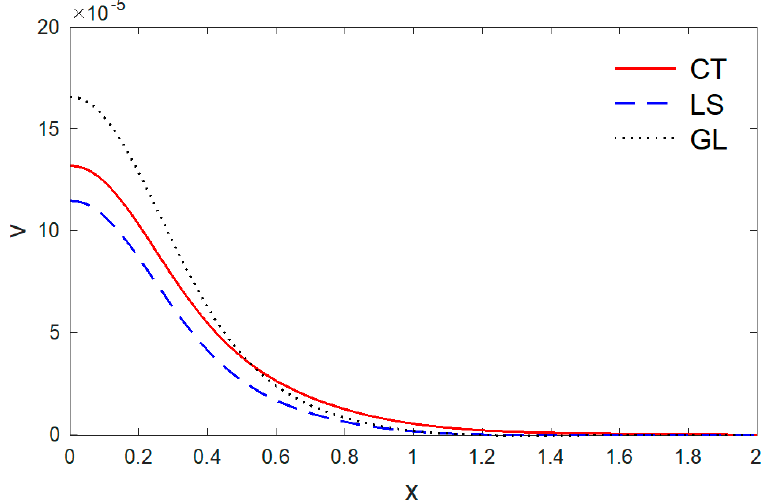
Figure 6. The vertical displacement variation v via x , with y = 0.5 under the three models.